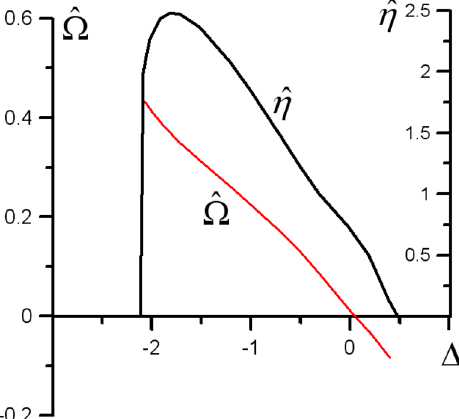
FIG. 6. (Color) Dependence of efficiency (black line) and fre- quency (red line) on the detuning parameter (cid:4) at L 1 ¼ 1 , L 0 ¼ 0 : 5 , ^ (cid:2) ^ (cid:2) 0 : 8 , and ^ (cid:3) ¼ 0 : 1 . 2 , L 2 ¼ 1 ¼ 2 ¼